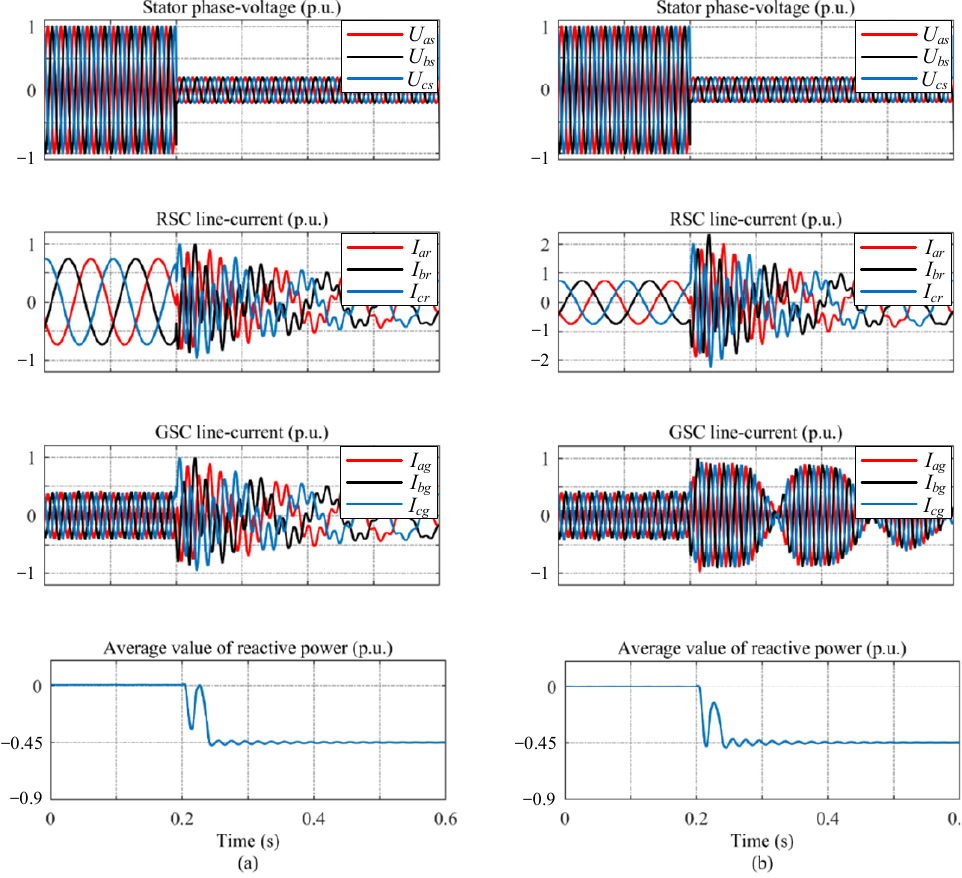
Figure 14. Reactive support capacity. ( a ) DISC. ( b ) Method-1.